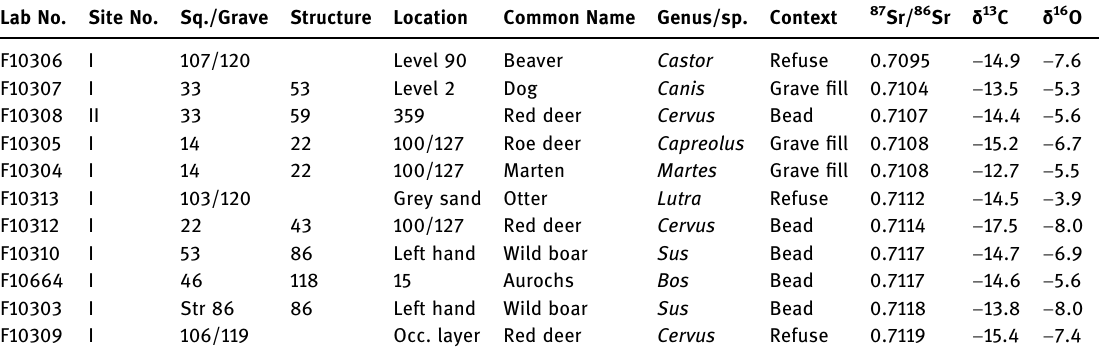
Table 1: Context and isotopic measurements for 11 animal teeth from Skateholm Lab No. Site No. Sq./Grave Structure